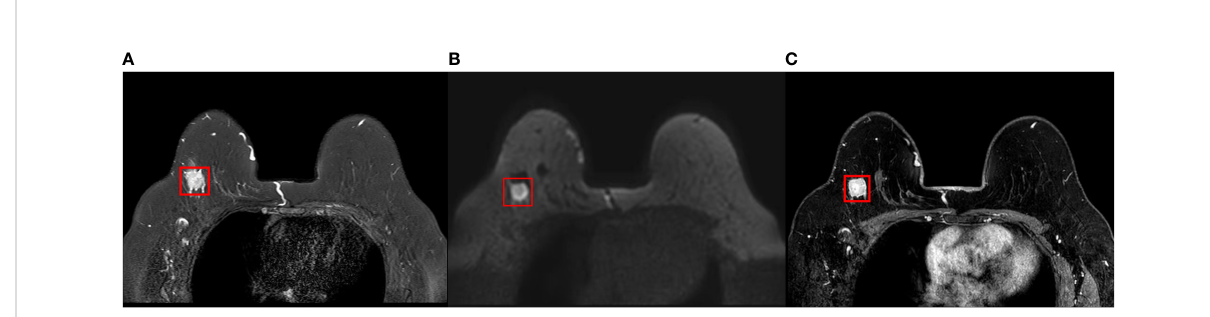
FIGURE 2 Cropping of ROI in raw MRI images of invasive breast cancer. (A) T2WI of the breast; (B) DWI of the breast; (C) Period with the most signi fi cant enhancement in DCE-MRI of the breast. ROI, region of interest; T2WI, T2-weighted imaging; DWI, diffusion weighting imaging; DCE-MRI, dynamic contrast-enhanced magnetic resonance imaging.